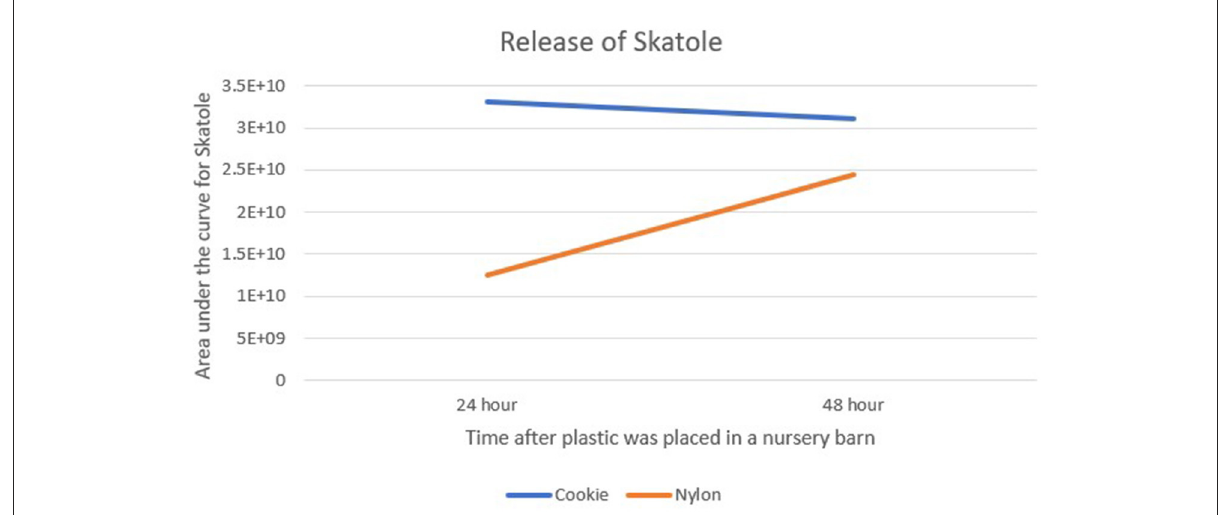
FIGURE5 Area under the curve for Skatole measured in the head space over EVA cookies or Nylon plastic then subjected to GC-MS analyses. Note that EVA cookies were higher than skatole release from nylon. Also, while EVA cookies were fairly stable over time, the nylon released more